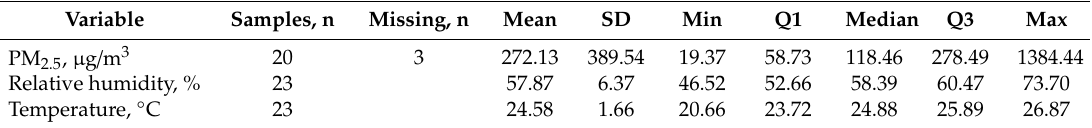
Table 2. Summary statistics for the mean of samples inside or outside a homes at a brick kiln